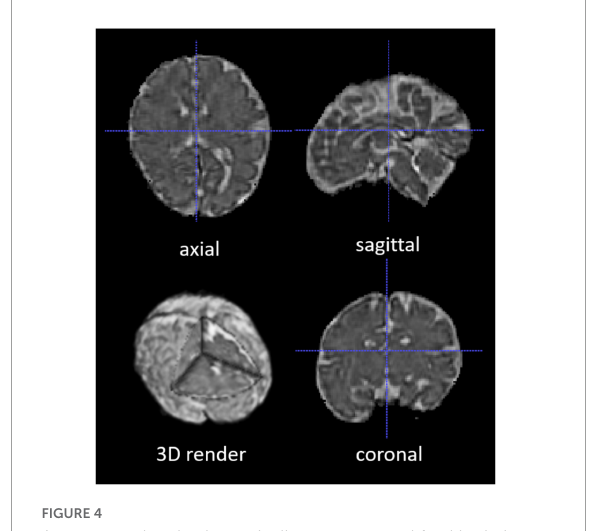
FIGURE4 A segmented and volumetrically reconstructed fetal brain image using NiftyMIC. The original 2D slices of fetal MR images were automatically segmented and manually adjusted for fetal brain 2D masks. Then the 2D slices and 2D brain masks were reconstructed into 3D volumes and 3D masks with motion correction. This figure shows an example of the skull-stripped, orientation-adjusted 3D fetal brain volumes in axial, sagittal, coronal, and 3D-rendered